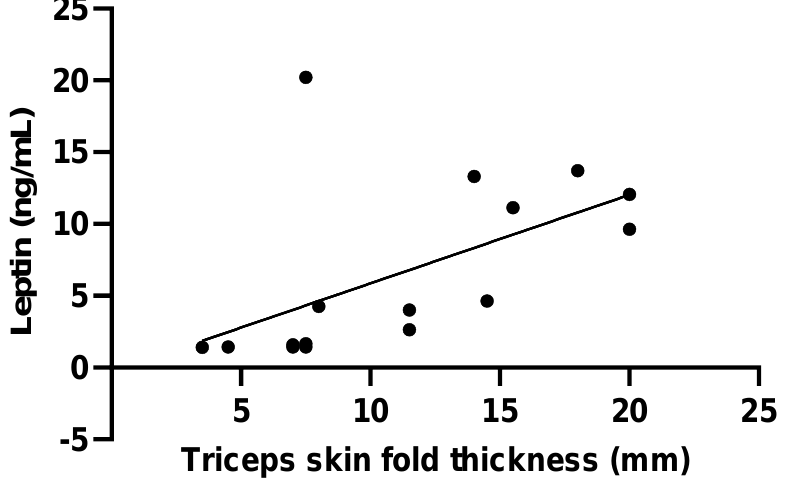
Figure 2. Plasma circulating leptin levels (ng/mL) in cirrhotic patients and healthy controls.